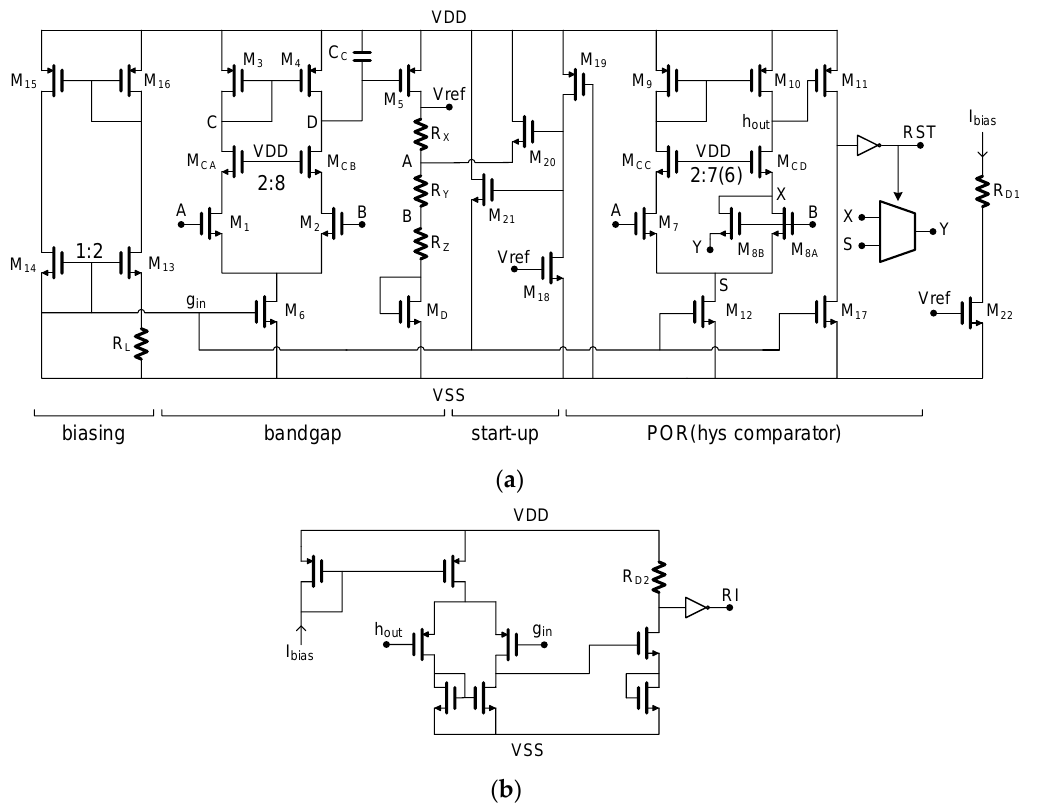
Figure 12. BGR#3 in CMOS 65 nm technology, 0.55 V supply voltage ( a ) core circuit ( b ) RI circuit.